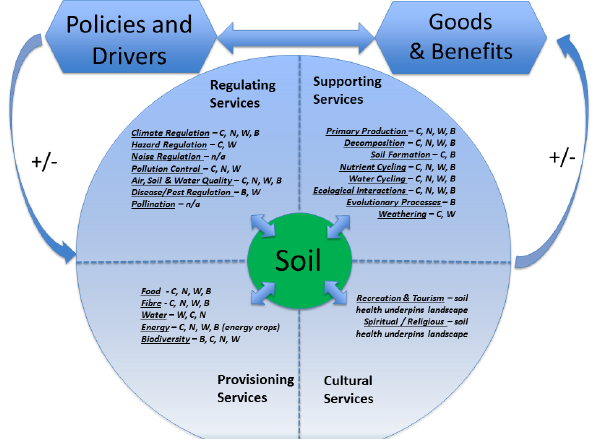
Figure 1. Schematic representation of where soil carbon, nutri- ent, and water cycles, and soil biota underpin ecosystem services (adapted from Smith et al., 2014). Role in underpinning each ecosystem service shown by C, soil carbon; N, soil nutrients; W, soil water; and B, soil biota. Only soil carbon, nutrient, and water cycles, and soil biota are considered, so the figure does not repre- sent a comprehensive overview of soil ecosystem services, which have been reviewed recently elsewhere (e.g. Robinson et al., 2013,